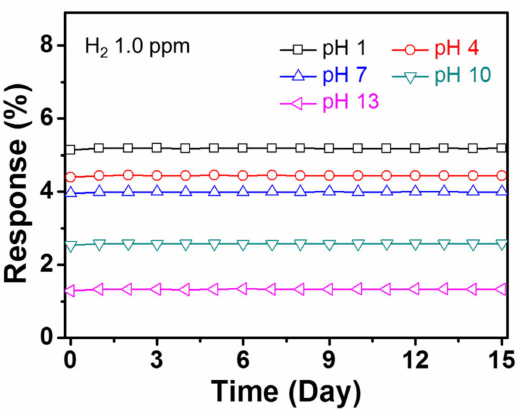
Figure 7. The normalized resistance changes of the electrodes with periodic exposures to 1 ppm of hydrogen gas for 15 days (black: pH 1; red: pH 4; blue: pH 7; green: pH 10; pink: pH 13).